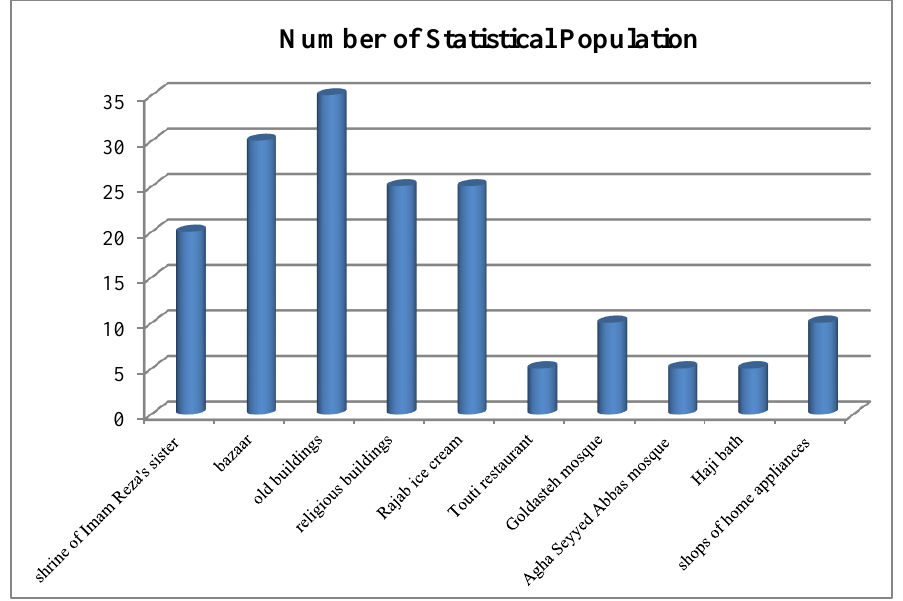
Figure 12. The most important signs of the neighbourhood from the view point of